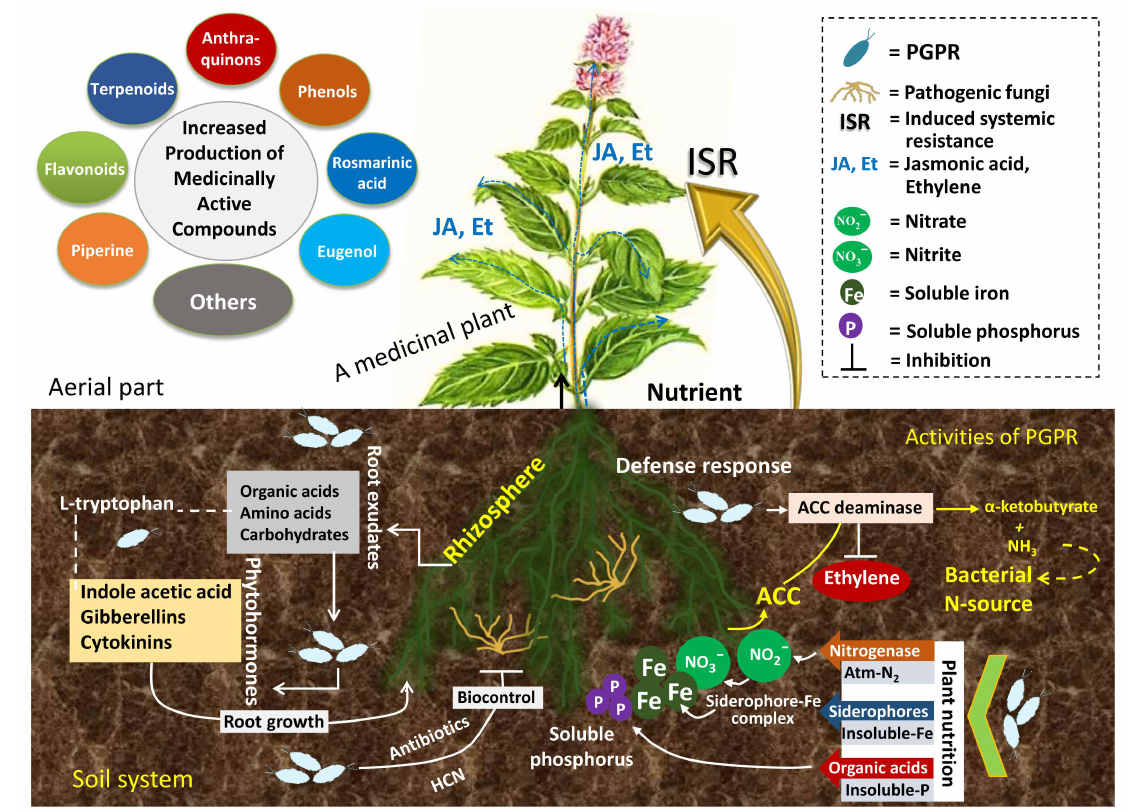
Figure 2. An overview of PGPR mediated nutrient mobilization, phytohormone supply and plant defence against microbial pathogens leading to the enhancement in the bio-chemical properties and yield of therapeutically bio-active compounds of medicinal plants growing under different environmental set